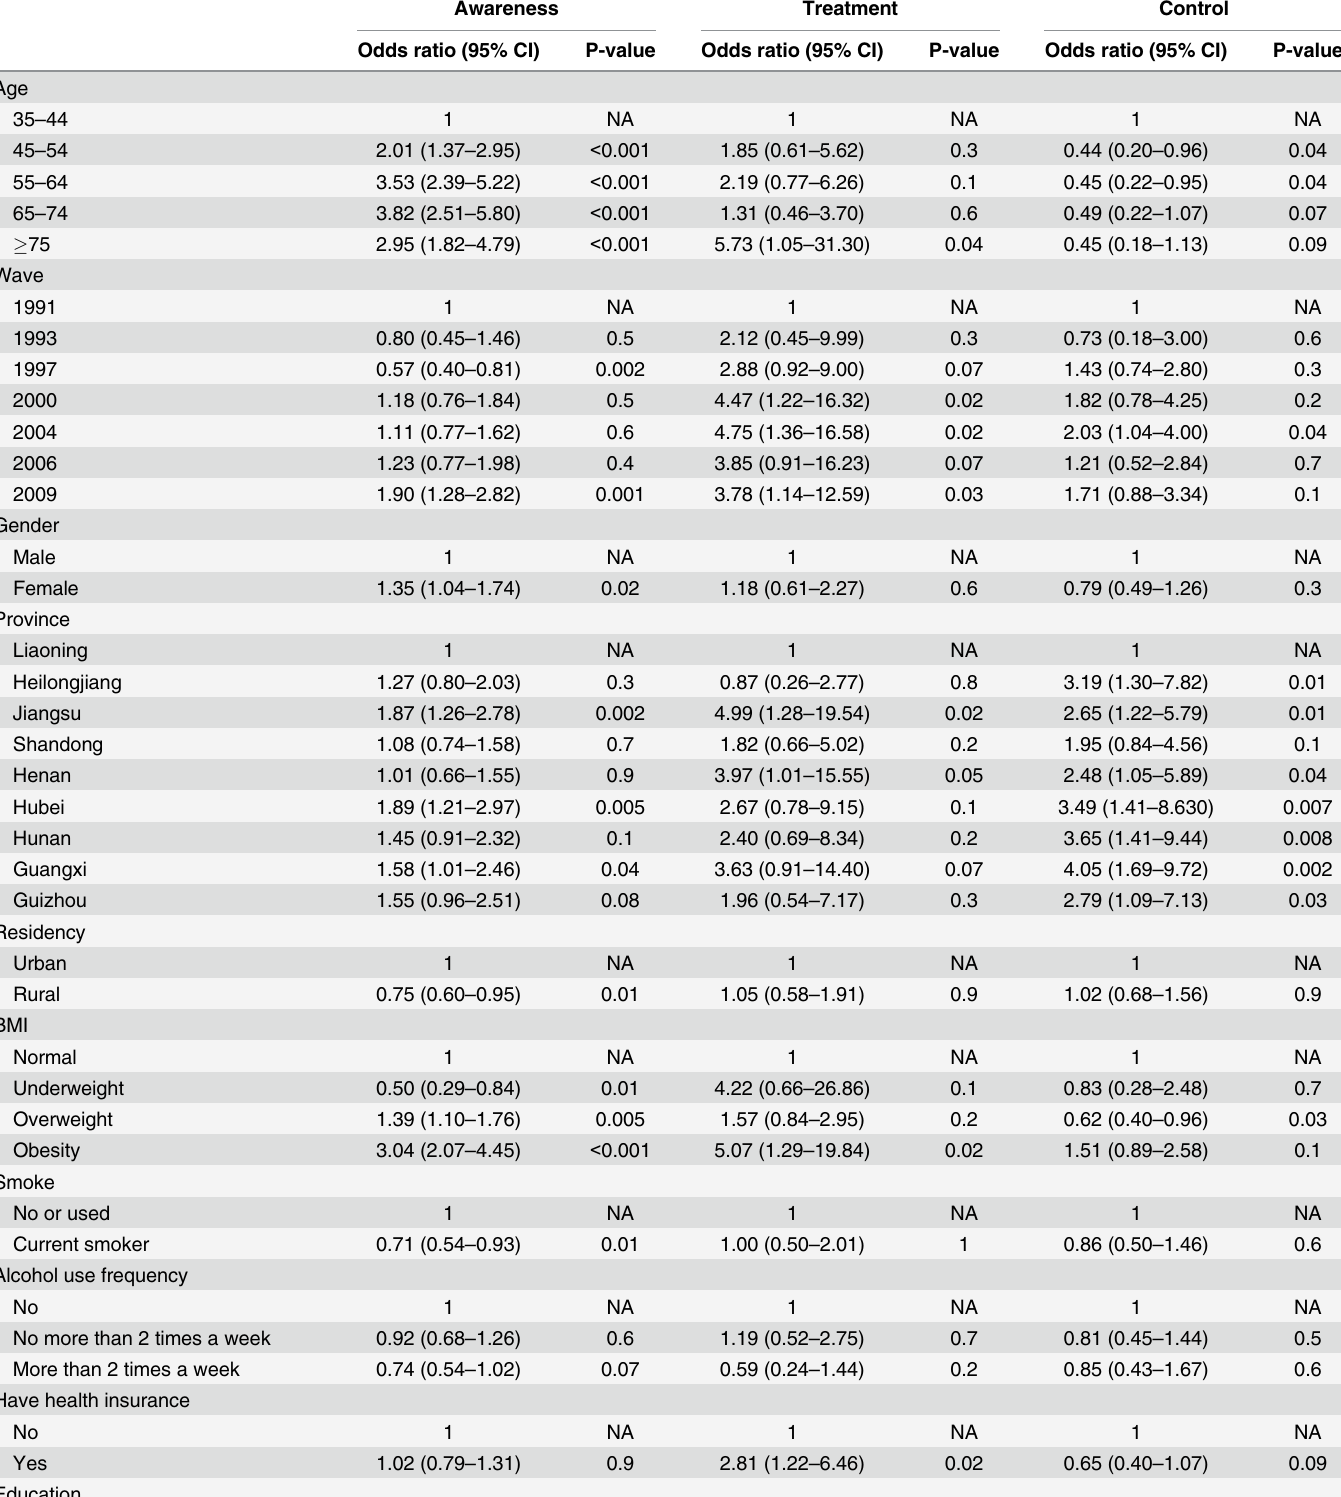
Table 4. Characteristics of management